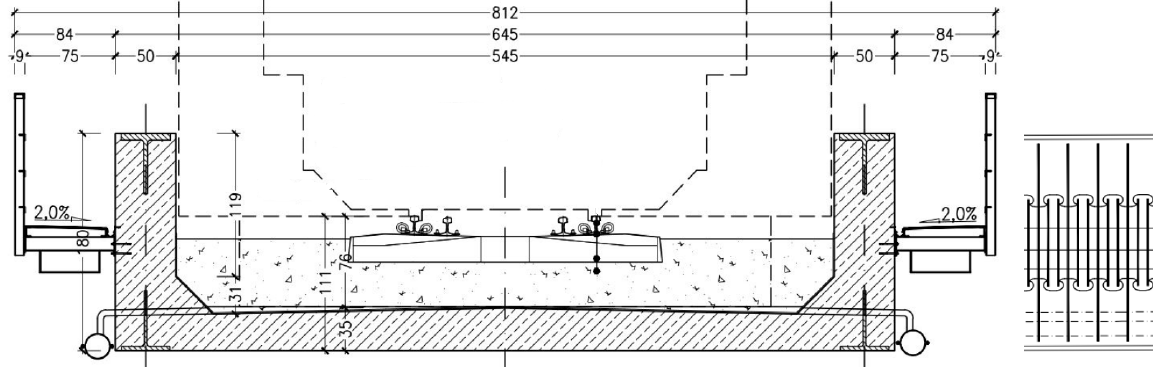
Figure 8: Cross section of the Dąbrowa Górnicza bridge and, on the right, longitudinal section showing the T-sections and rebar arrangement in the girder’s